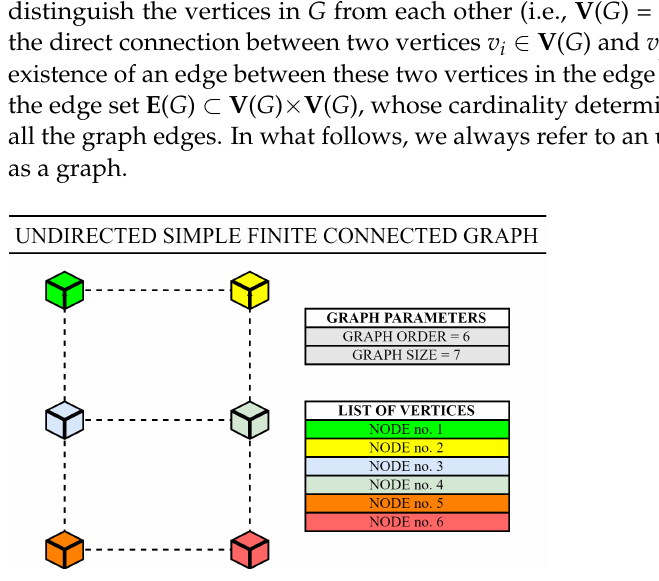
Figure 6. Example of undirected simple finite connected graph with graph order equal to 6 and graph size equal to